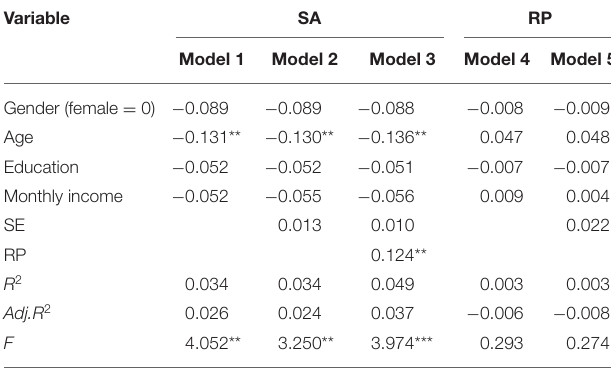
TABLE 6 | Regression test of mediating effect after pandemic ( N = 466).